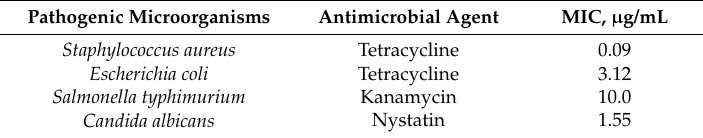
Table 1. Minimum inhibitory concentration (MIC) values of the antimicrobial agents used.